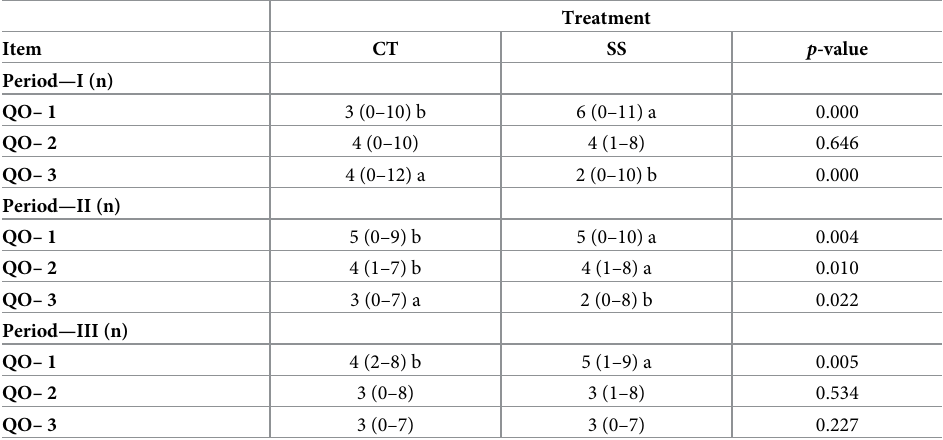
Table 5. Data from scan sampling method on quadrant occupation for growing and finishing pigs (presented in median / min—max).